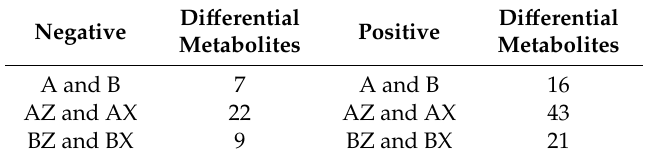
Table 4. Metabolite statistics of litter di ff erence (variable importance in projection (VIP) ≥ 1 and p ≤